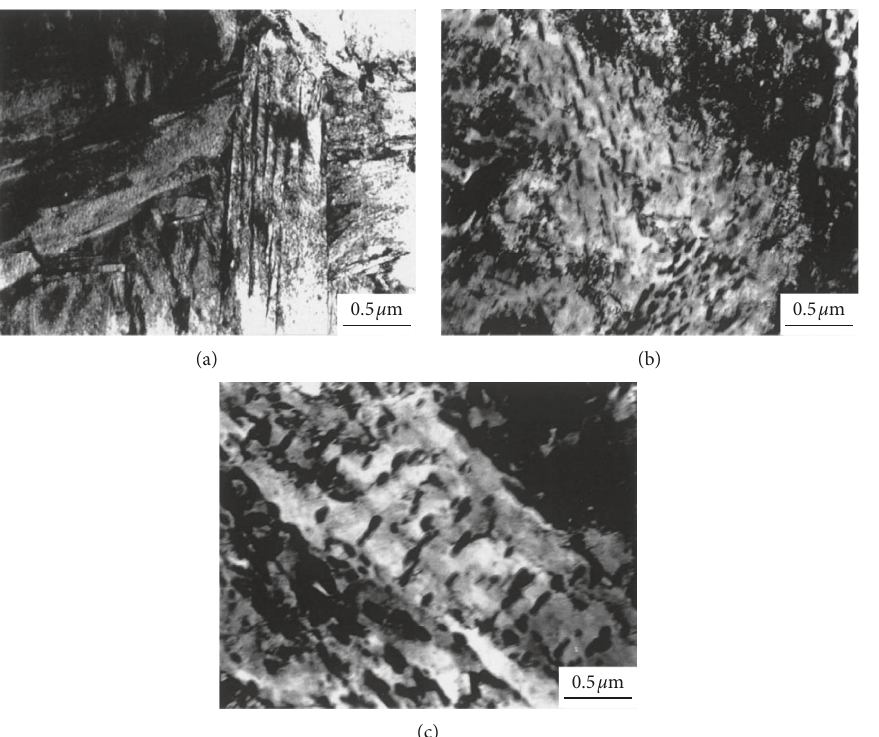
Figure 10: The TEM micrographs of 34CrNiMo6-xCe specimens quenched in oil (870 ° C/30 min) and tempered at 650 ° C: (a) x quenched in oil; (b) x 0, quenched and tempered; (c) x (cid:31)